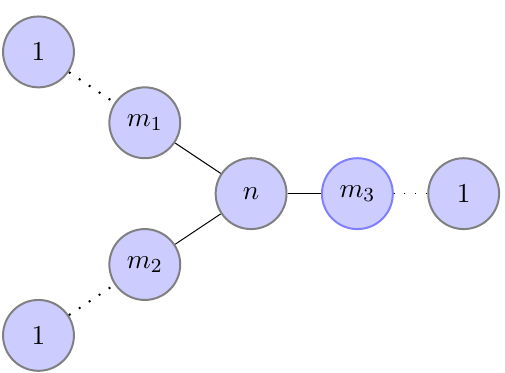
theory. Nodes and lines are ( m 1 ;m 2 ;m 3 )